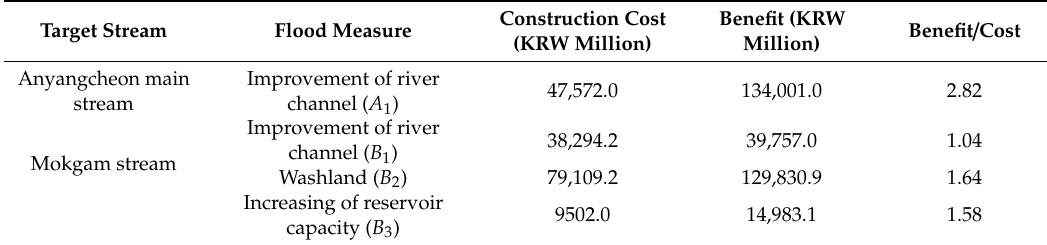
Table 4. Construction cost, benefit, and Benefit / Cost (B / C) of feasible flood measures.